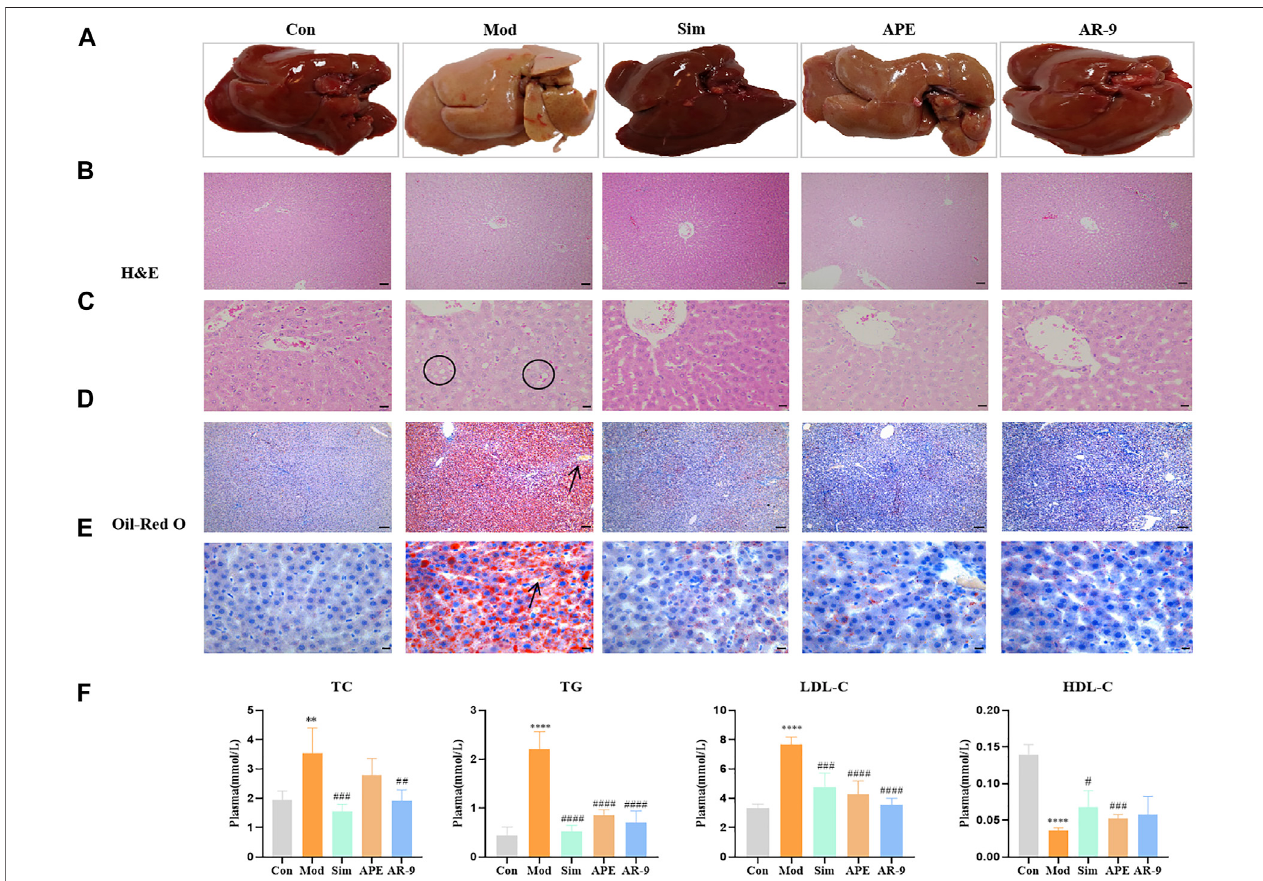
FIGURE 2 | Results of anti-HL activity of AR-9. Con: control group, Mod: high-fat diet group, APE: APE treatment group, and Sim: simvastatin calcium administration group. (A) Rat liverphotographs intest groups. (B) H&Estaining (scale bar,200 μ m) ofratliversin groups. (C) H&Estaining(scale bar, 50 μ m) ofrat livers in groups. (D) Oil RedOstaining(scalebar,500 μ m) ofratliversingroups, and (E) Oil-Red Ostaining(scale bar,50 μ m)ofratliversin groups. (F) Hypolipidemiceffectof AR-9 (TC, TG, LDL-C and HDL-C levels in the plasma of rats). n = 5 – 6. * p < 0.05, ** p < 0.01, *** p < 0.001, and **** p < 0.0001 and # p < 0.05, ## p < 0.01, ### p < 0.001, and #### p < 0.0001 vs. Con or Mod group. The arrows indicate lipid droplets. The circles indicate vacuolar hepatic